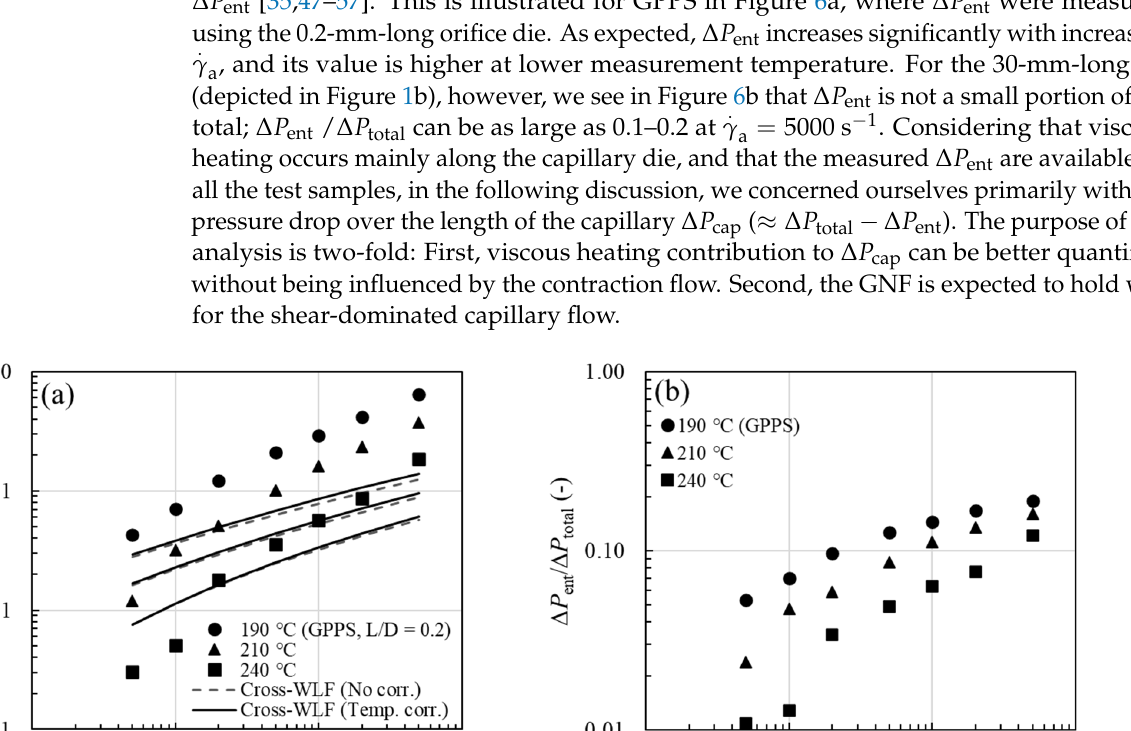
. γ a for GPPS. ( b ) Fraction of the entrance pressure